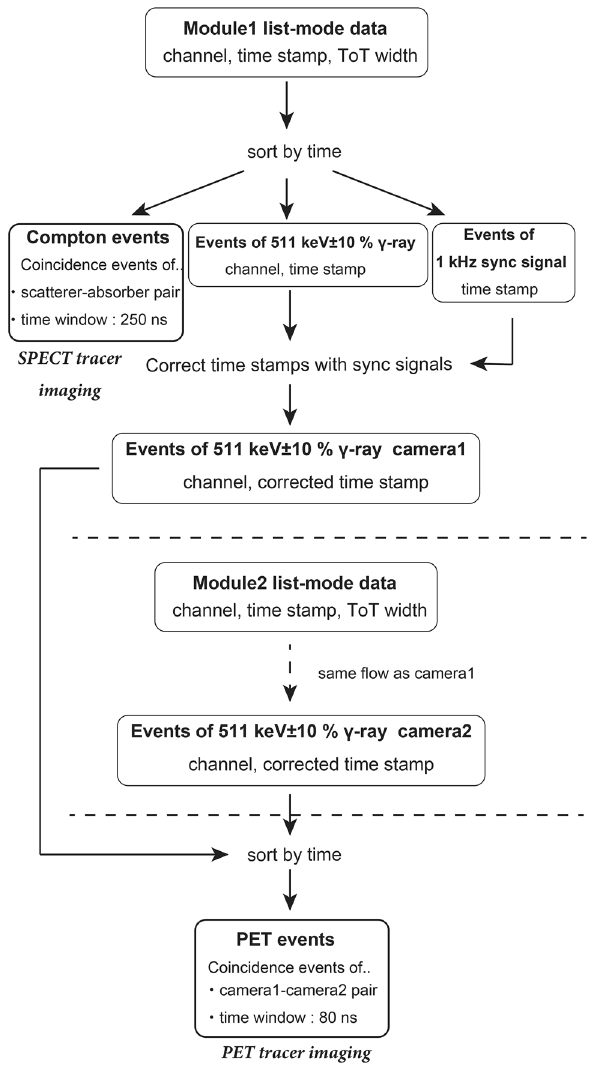
Figure 7. Analysis flow. List-mode data from each module contain information about the pixel channel, time stamp, and ToT width. First, all events from each module are sorted by time. Next, Compton events (events within 250 ns in a scatterer and an absorber), 511 keV gamma-ray-peak events, and sync-signal time stamps are extracted from each module’s data. Compton events are used for SPECT-tracer imaging. PET events (events within 80 ns in opposing absorbers) are extracted from the integrated photo peak events in the two modules after correcting the time stamps using the sync signals. PET events are used for PET-tracer